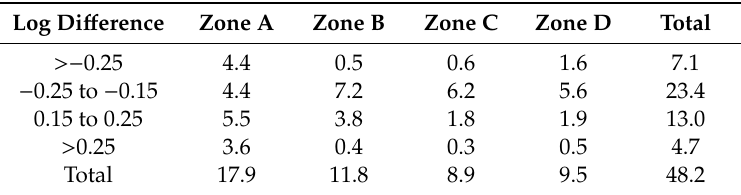
Table 4. Zonal statistics using the VH polarization for each log difference threshold and zone (Zone A to Zone D). Areas are measured in hectares (10,000 square meters).